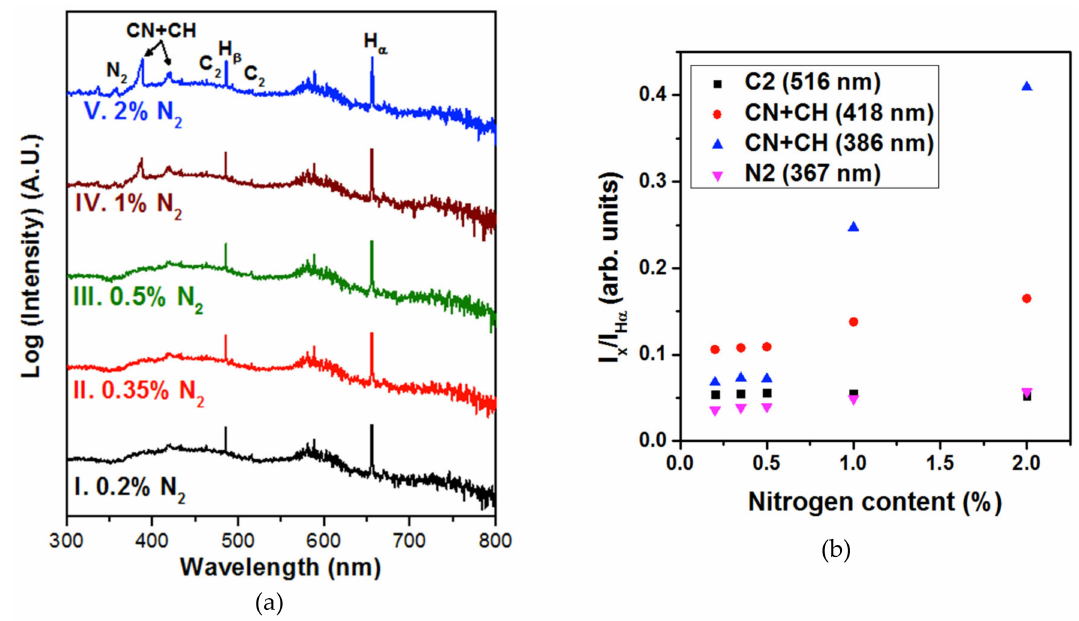
Figure 8. ( a ) OES spectra recorded during the deposition process of the five samples labelled by their N 2 amount. ( b ) Intensity of C 2 , N 2 , and CN + CH peaks normalized to the H α peak for each nitrogen content